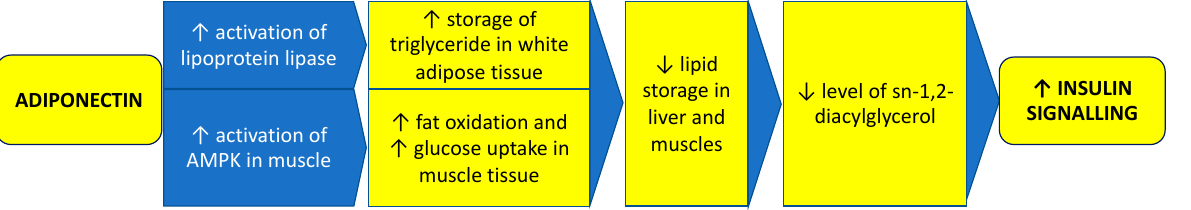
Figure 3. Role of adiponectin in maintaining proper insulin signaling. Adiponectin reduces lipid storage in the liver and muscles, which results in decreased membrane sn-1,2-diacylglycerol levels and increases insulin signaling. Adiponectin mediates these effects by promoting the storage of tri- glyceride in white adipose tissue through stimulation of lipoprotein lipase and by increasing muscle fat oxidation and glucose uptake by stimulation of 5’ adenosine monophosphate-activated protein kinase (AMPK) in muscle.